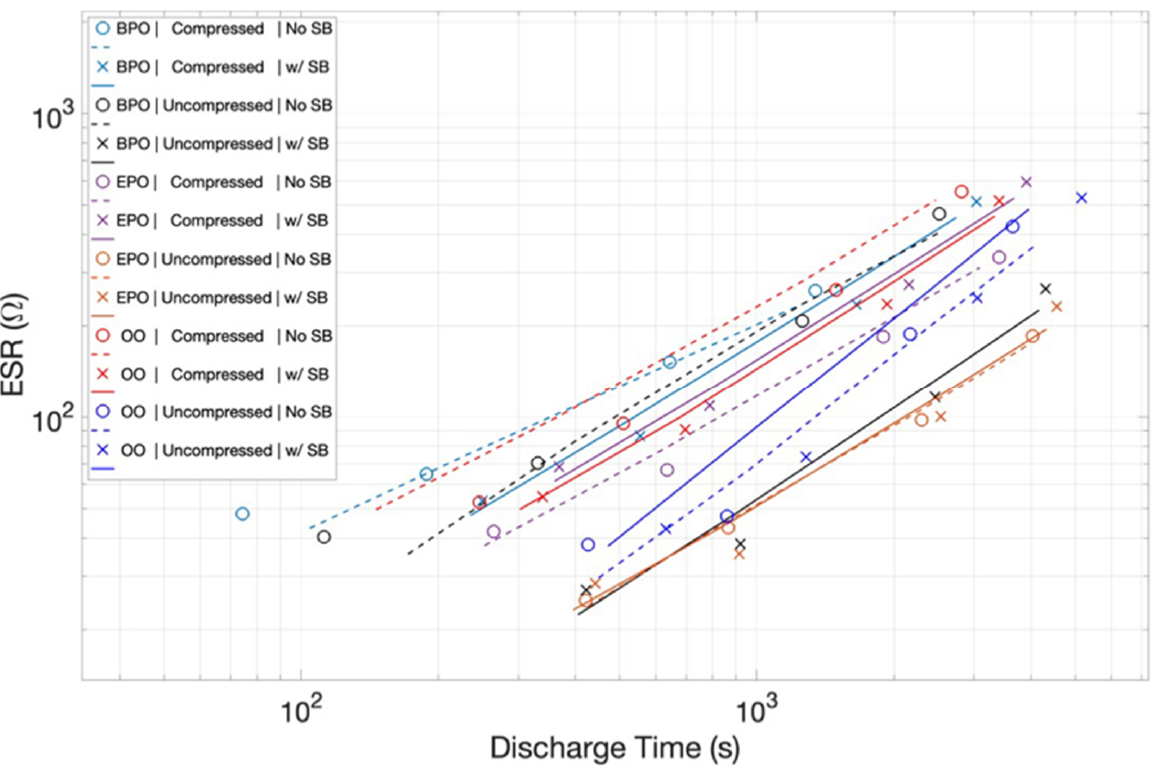
Figure 10. ESR of all capacitors as a Function of Discharge Rate. It is notable that ESR is a strong function of discharge time for all capacitors studied.